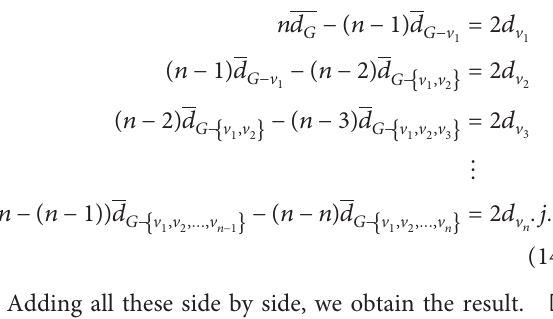
Figure 2: The graph G − v